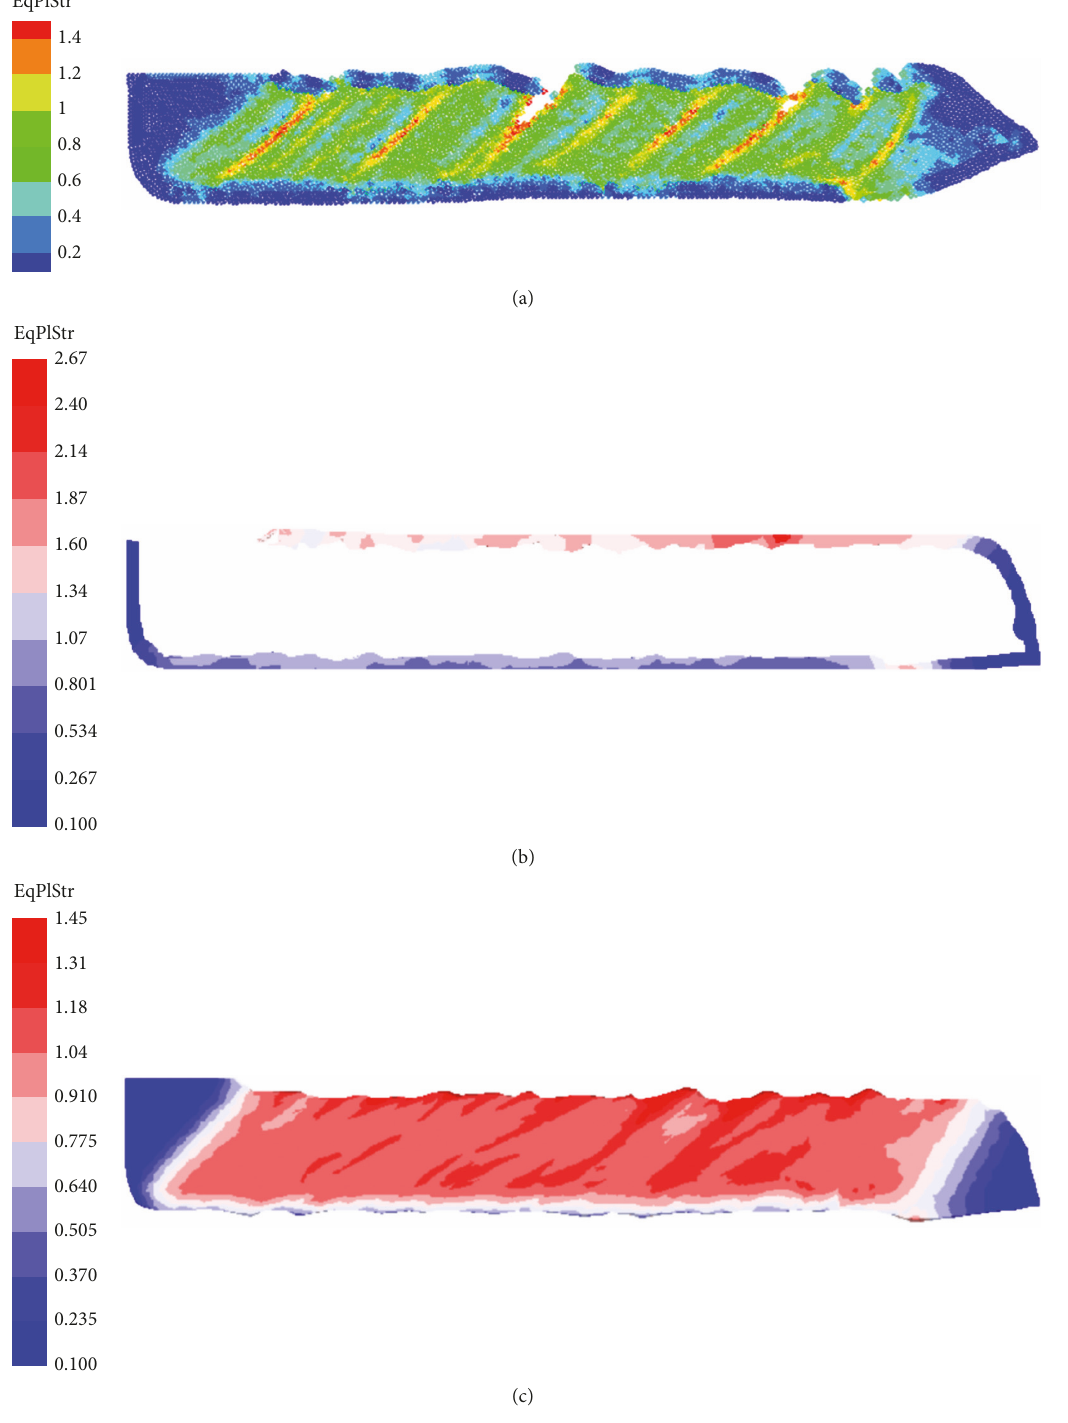
Figure 12: Simulation results of equivalent strain distribution. (a) Computation results based on SPH. (b), (c) Computation results based on finite element